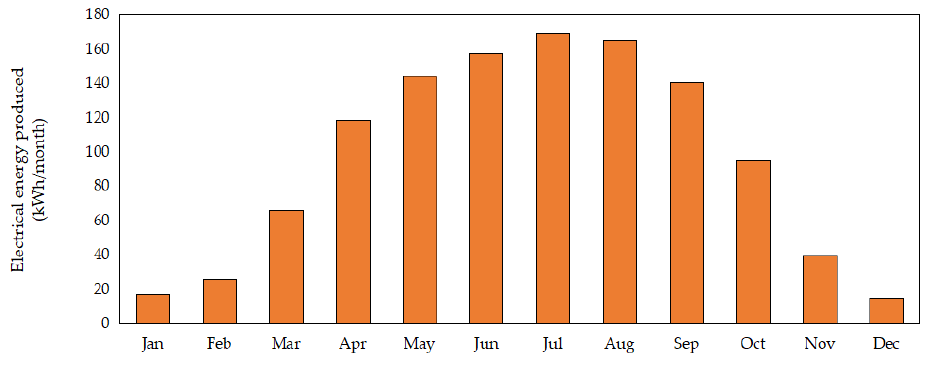
Figure 14. Overall electrical energy produced by SPBs.